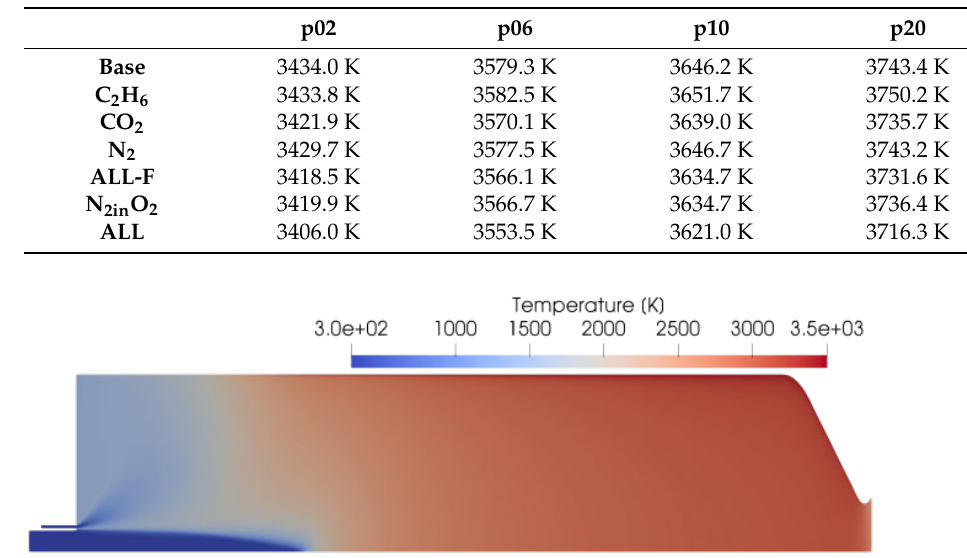
Figure 7. Temperature within the combustion chamber for Test Case C2H6/p06.